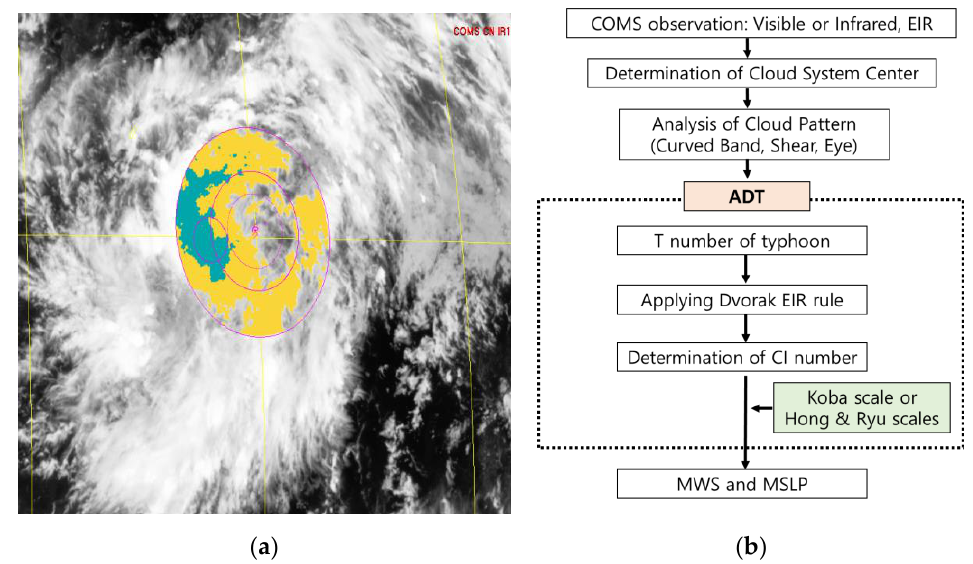
Figure 3. ( a ) Example of TC cloud system center (CSC) determination from the COMS imagery and ( b ) procedure for estimating MWS using ADT and COMS satellite observations.